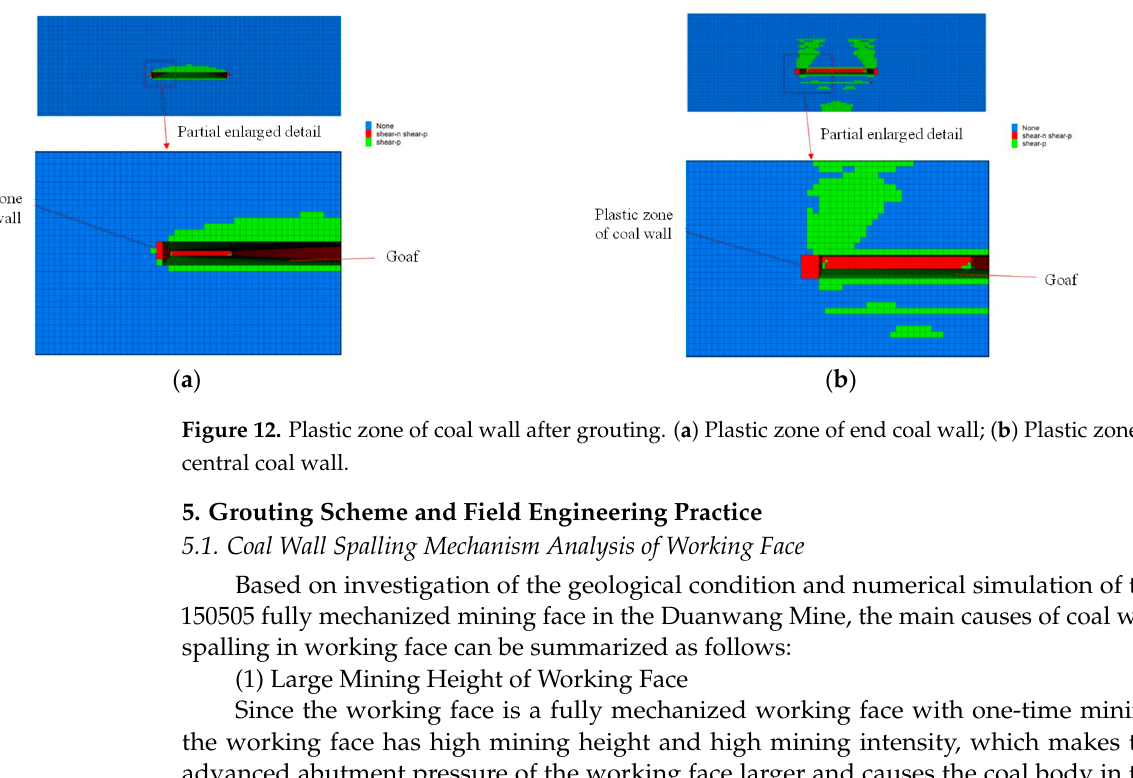
Figure 12. Plastic zone of coal wall after grouting. ( a ) Plastic zone of end coal wall; ( b ) Plastic zone of central coal wall.